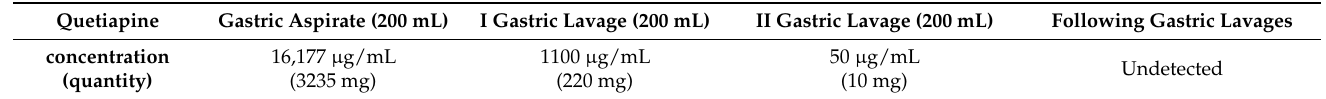
Table 2. Gastric aspirate and liquid of gastric lavage concentration of